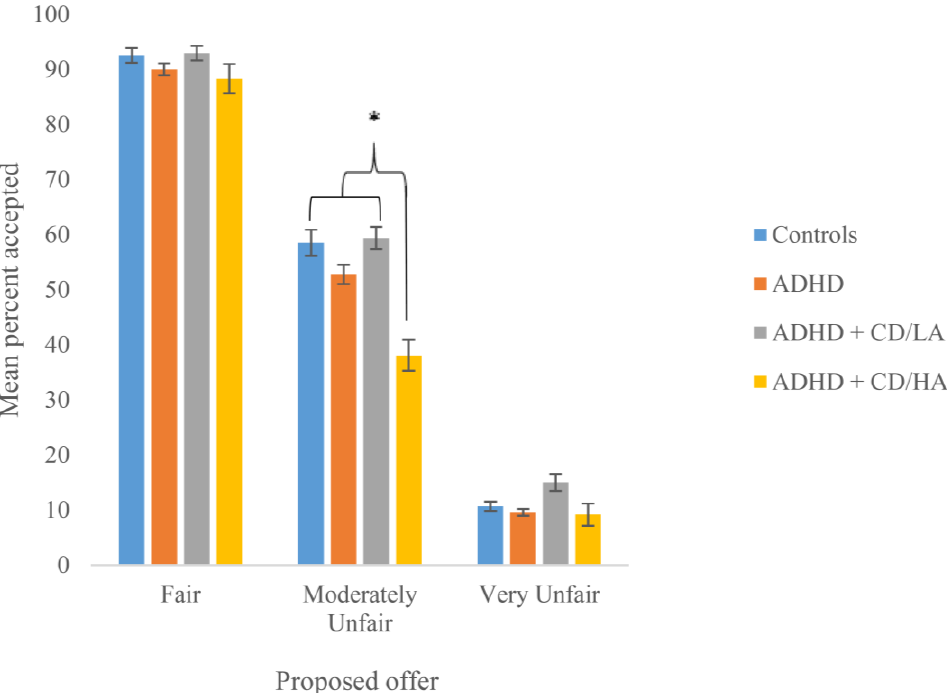
Figure 1. Percentage of Ultimatum Game offers accepted by adolescent males; normal controls, ADHD only, ADHD + CD/LA and ADHD + CD/HA. Error bars show ±1 SE. * p <